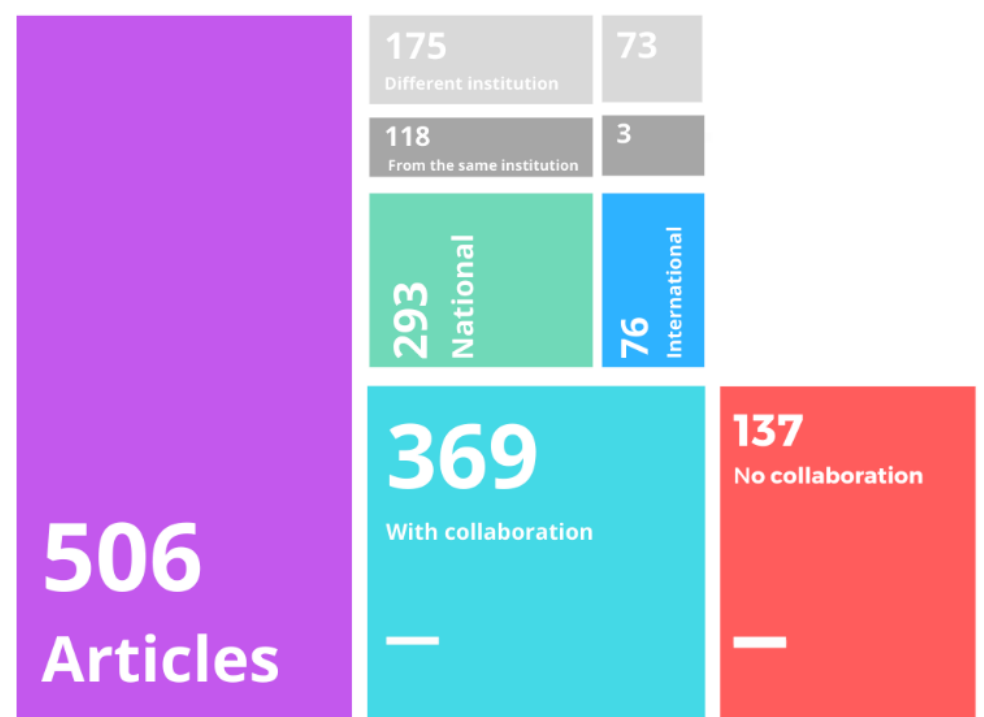
Figure 6. Distribution of collaboration in the knowledge area. Source: Authors’ own data .